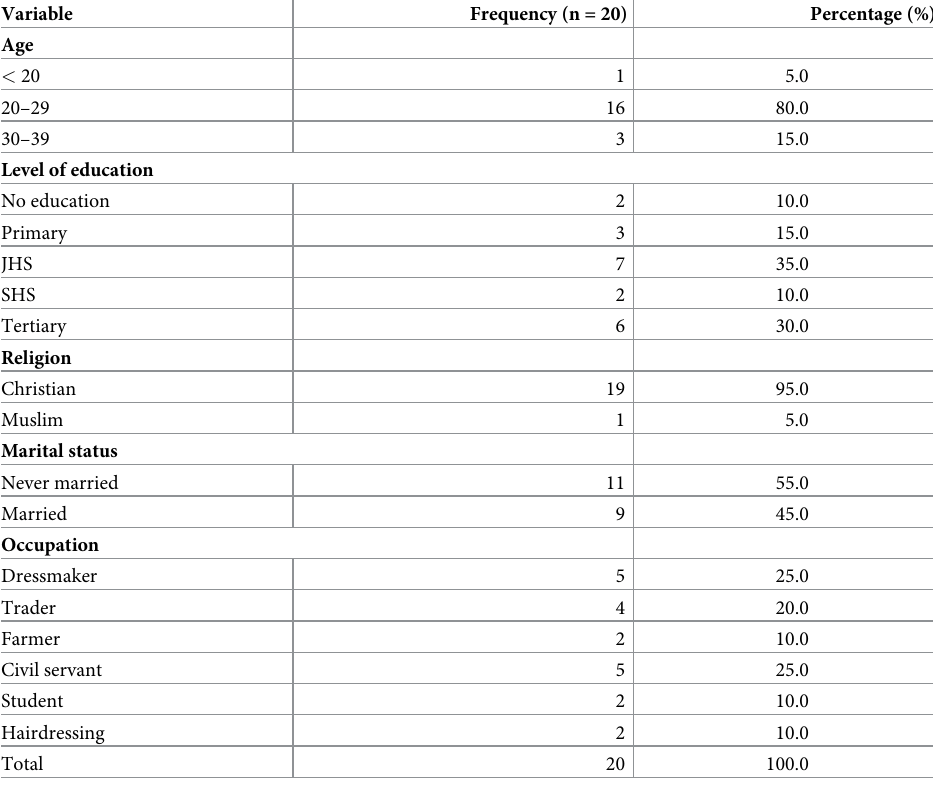
Table 1. Socio-demographic characteristics of